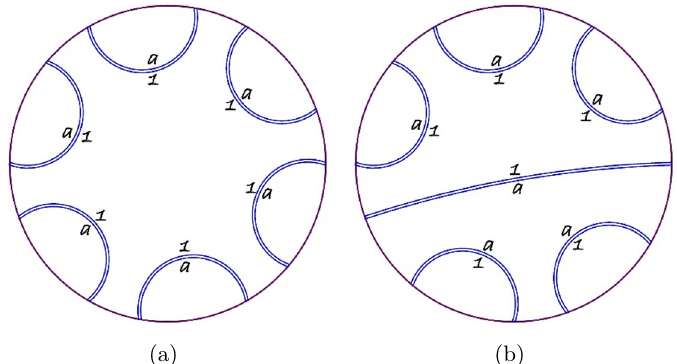
Figure 3 . Diagrams that contribute to the one-point function. The operator is depicted as a circle, to visualize the color trace. In spacetime the operator is a point, and all the propagators produce the vacuum bubble D (0). Di(cid:11)erence in the index structure allocates the two diagrams to di(cid:11)erent orders in 1 =N : (a) The leading-color contribution, in this case O ( N 6 ). (b) A subleading diagram, contributing at O ( N 4